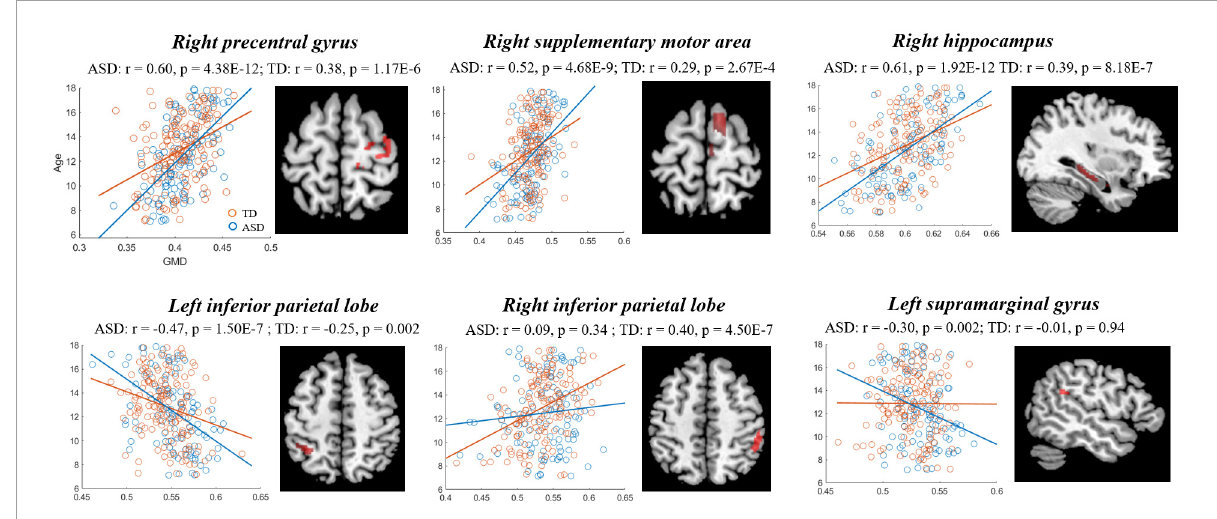
FIGURE3 Correlations between gray matter density (GMD) and age showing significant differences between autism spectrum disorder (ASD) and typically developing (TD). Blue and red represent the ASD and TD, respectively.